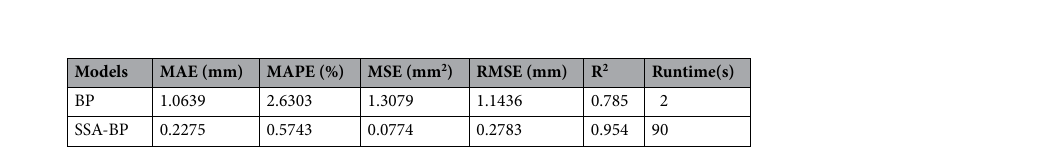
Table 7. Evaluation index value and average running time of BP, SSA-BP at P2.